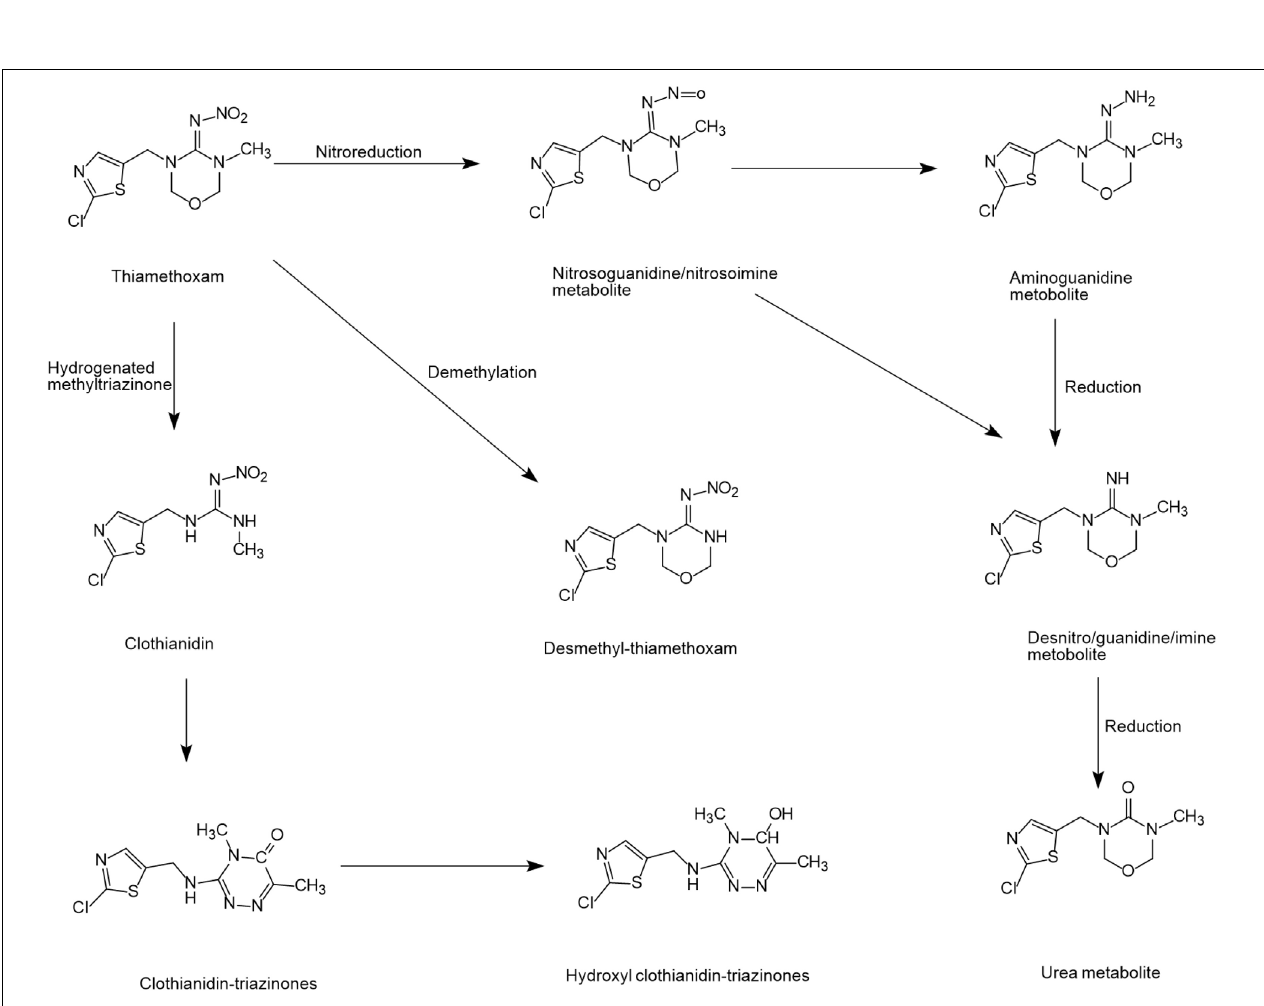
FIGURE 4 | Microbial degradation pathways of thiamethoxam (based on Pandey et al., 2009; Zhou et al., 2014).